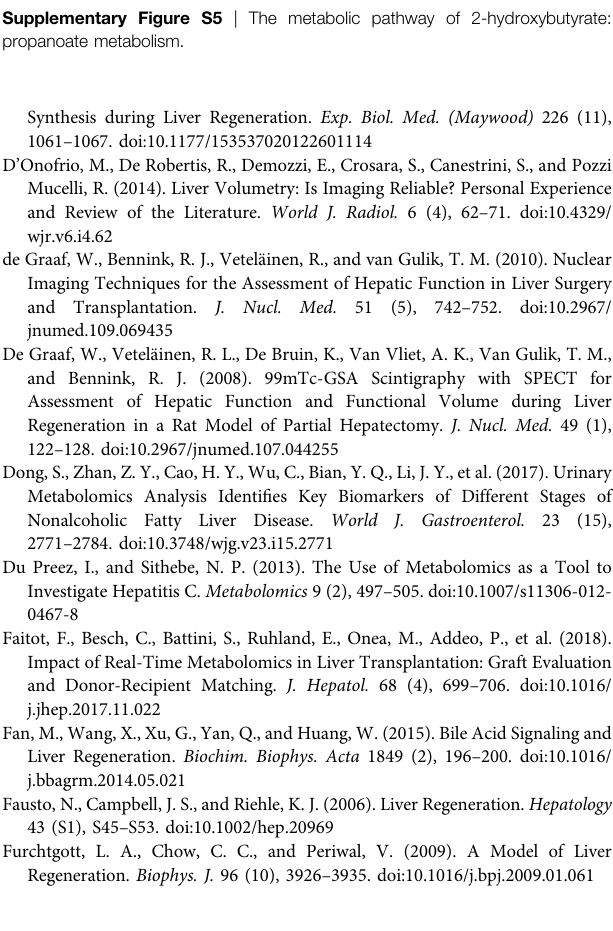
Supplementary Figure S2 | The metabolic pathway of ornithine: arginine and ornithine metabolism. Supplementary Figure S3 | The metabolic pathway of ornithine: glutathione metabolism. Supplementary Figure S4 | The metabolic pathway of phenylalanine and lysine: tropane, piperidine, and pyridine alkaloid biosynthesis. Supplementary Figure S5 | The metabolic pathway of 2-hydroxybutyrate: propanoate